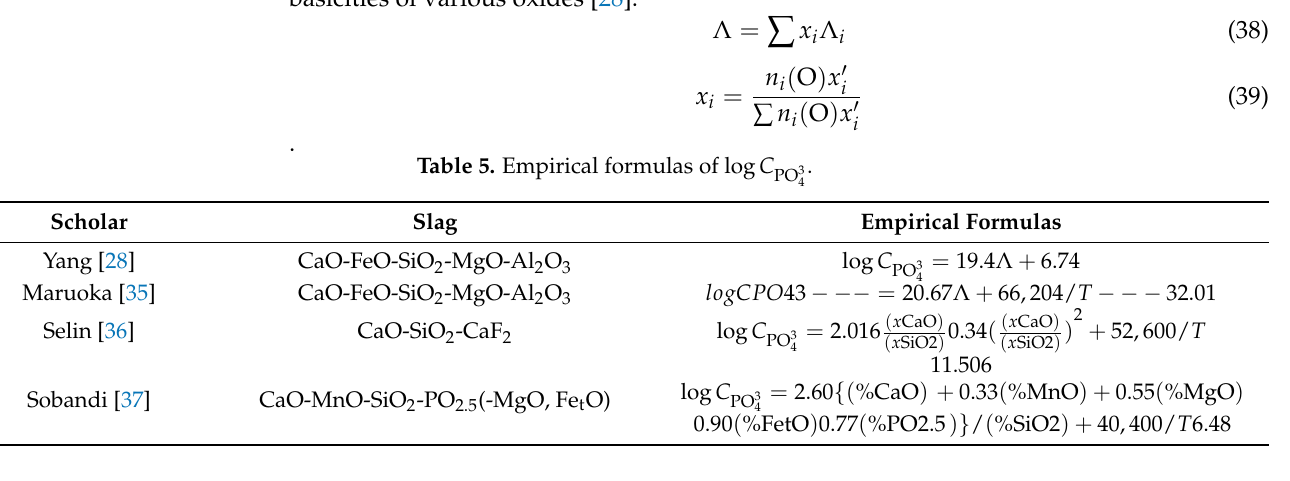
Table 5. Empirical formulas of log C